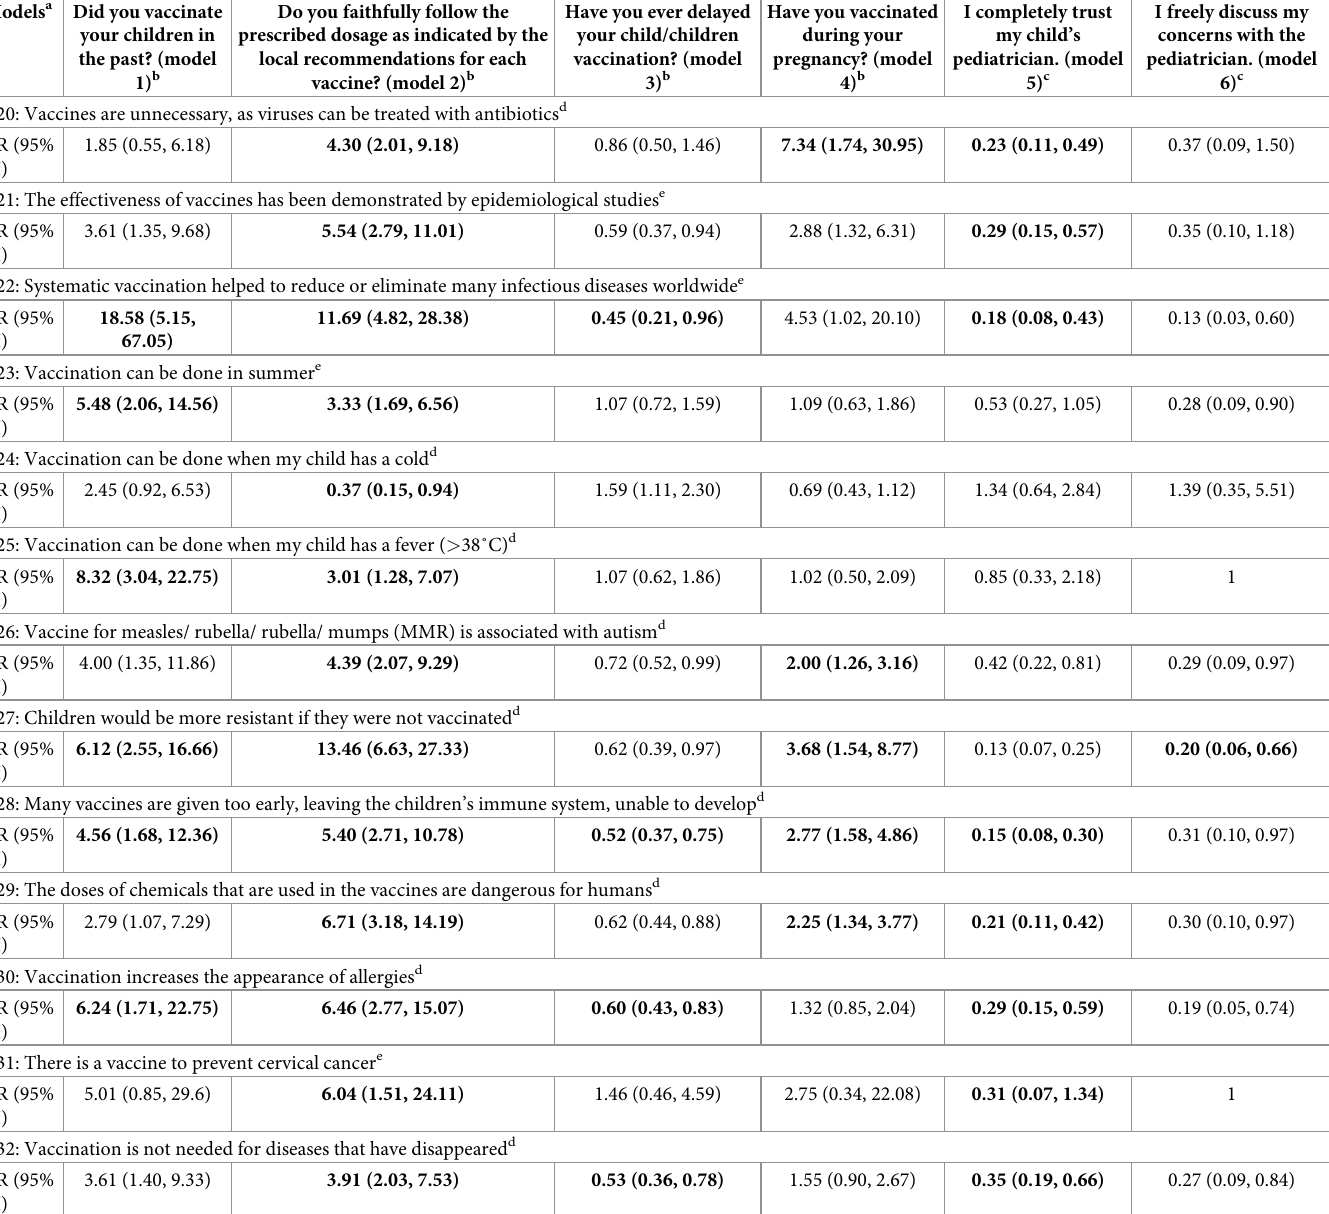
Table 5. Multiple logistic regression models [(with odds ratios (ORs) and 95% confidence Intervals (CI)] for the association between mothers’ knowledge about vac- cination and vaccination status of children and their mother during pregnancy, mothers’ attitudes to the pediatrician. Models a Did you